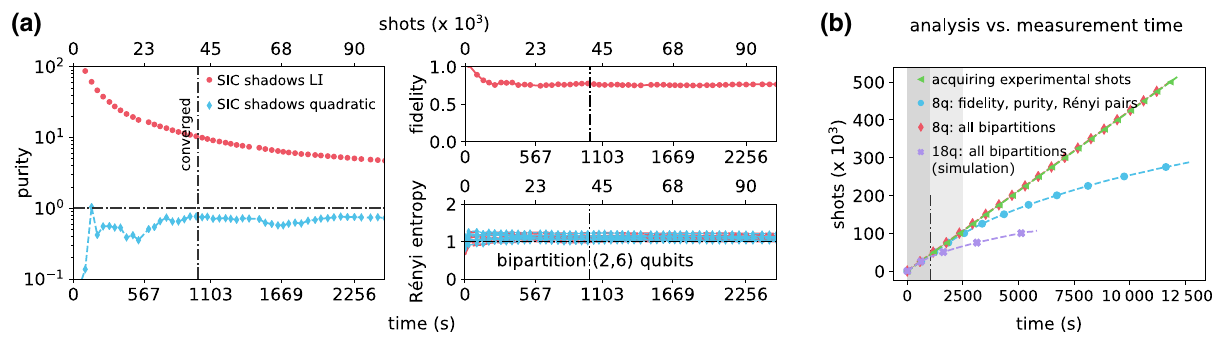
FIG. 5. Live-update SIC tomography of a maximally entangled eight-qubit state. We prepare a locally rotated GHZ state and probe the state via live-update SIC tomography. The local π/ 4 rotation ensures that the state is not aligned with any tomography basis and can serve as a proxy for an arbitrary entangled state. Data analysis is performed in parallel to data acquisition to get the quickest possible feedback. Shot-by-shot reconstruction is realized via classical shadows [Eqs. (4)–(A20)]. (a) Experimental results on purity (left), fidelity (middle top), and all ( 2, 6 ) -qubit bipartition Rényi entropies (middle bottom) obtained live in a time regime where the data acquisition time dominates. We find the purity from classical shadows to have converged after less than 1000 s, with the other measures converging significantly faster. Fidelity converges very fast below 500 s and Rényi entropies saturate almost immediately. Note that, for the latter, the curves for SIC shadows LI and SIC shadows quadratic overlap due to the fast convergence for small subsystem sizes. The dash-dot line indicates the ideal value. (b) Comparison of the time for data acquisition (left-pointing triangles) following the expected linear curve along times curves for data analysis utilizing different methods and metrics covering the entire 12 500 s of data taking. When analyzing fidelity, purity, and all ( 2, 6 ) -qubit bipartition Rényi entropies (circles) as shown in the experimental results of (a), live update is possible for around 2500 s. This is expected, since the shot-by-shot data analysis scales quadratically with the total shot number; see Eq. (6). Estimating only Rényi entropies for all bipartitions (diamonds), on the other hand, remains feasible for the entire time as it overlaps with data acquisition (left-pointing triangles) following the linear curve. Additionally, we simulate the estimation of all Rényi entropies of an 18-qubit (18q) state (crosses) by considering the data acquisition overhead (left-pointing triangles), demonstrating that this in principle also remains feasible to perform